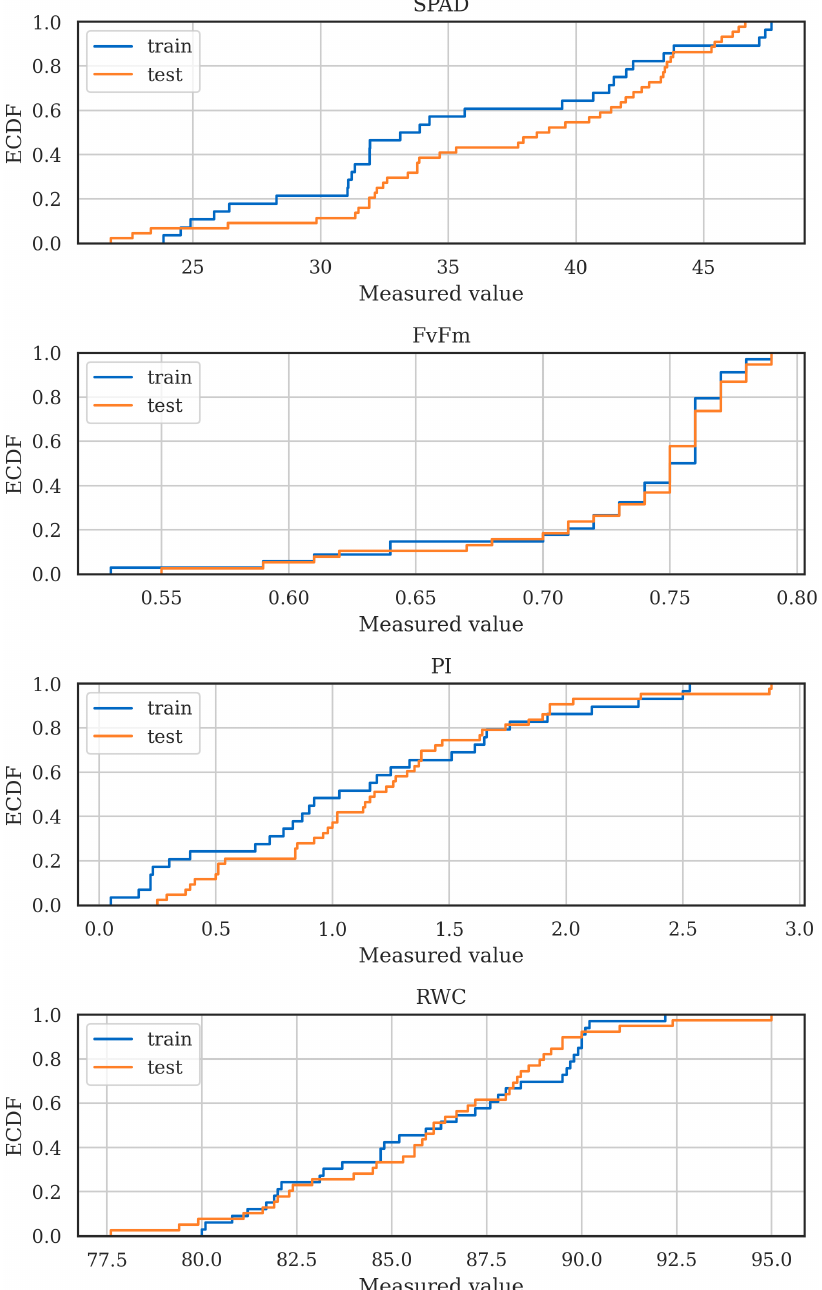
Figure 3. Empirical cumulative distribution (ECDF) of all parameters (SPAD, FvFm, PI and RWC) in the training and test